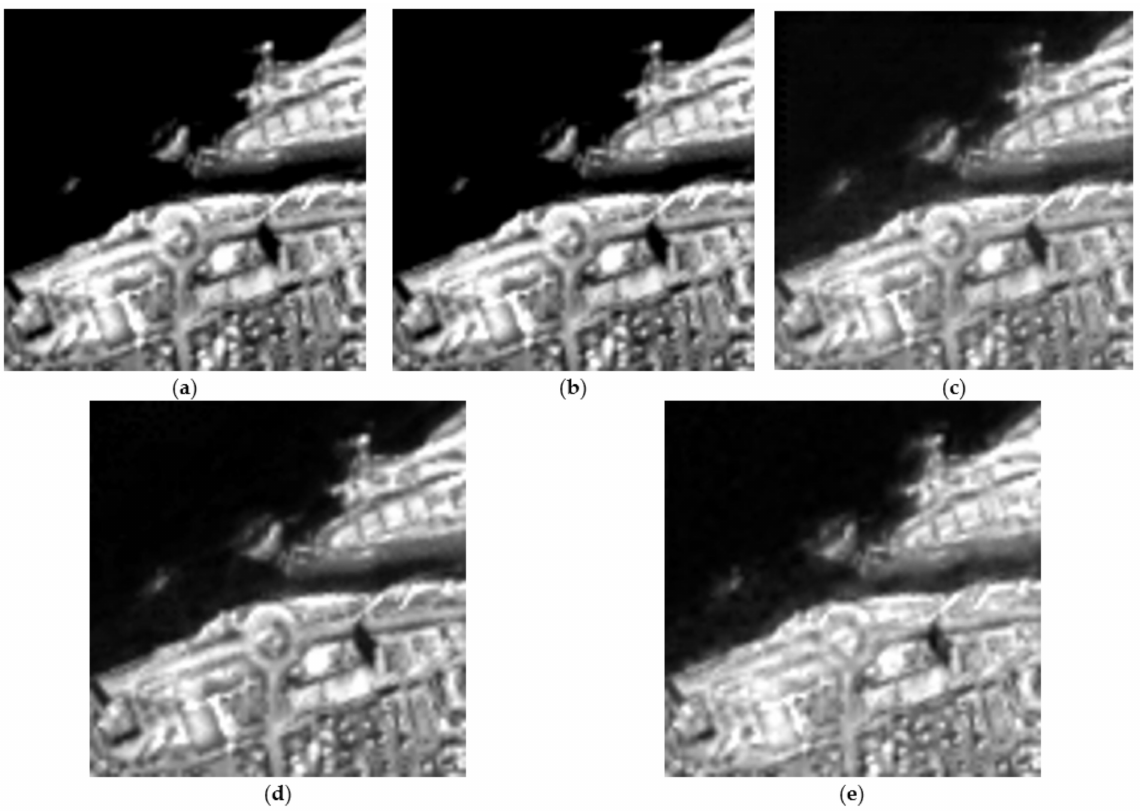
Figure 9. Spectral band in the 0.854 µ m region. ( a ) Obtained HSB-SV sharpened hyperspectral image; ( b ) Obtained HMF-IPNMF sharpened hyperspectral image; ( c ) Obtained HySure sharpened hyperspectral image; ( d ) Obtained CNMF sharpened hyperspectral image; ( e ) Obtained FuVar sharpened hyperspectral